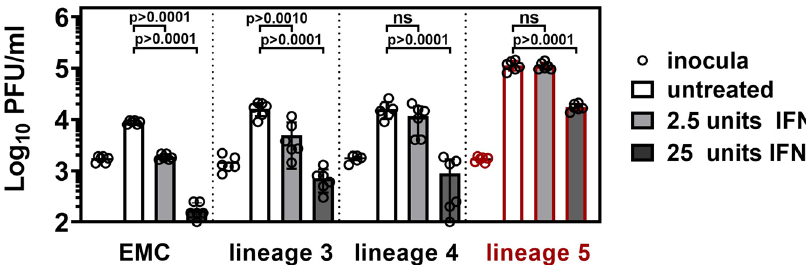
Fig. 8 Lineage 5 MERS-CoV isolates show decreased IFN sensitivity. Calu-3 cells were incubated for 16 h with 2.5 or 25 units type-I interferon (IFN) prior to infection at MOI = 0.002 with MERS-CoV isolates of the indicated lineages. Inoculum and virus progeny in culture supernatants were quanti fi ed by plaque assay 24 hpi. Infections were performed in biological triplicates with n = 2 virus isolates per lineage and the experiment was repeated three times. Shown is the mean PFU/ml of n = 3 independent experiments with bars indicating the mean and error bars indicating SD. Statistical signi fi cance of